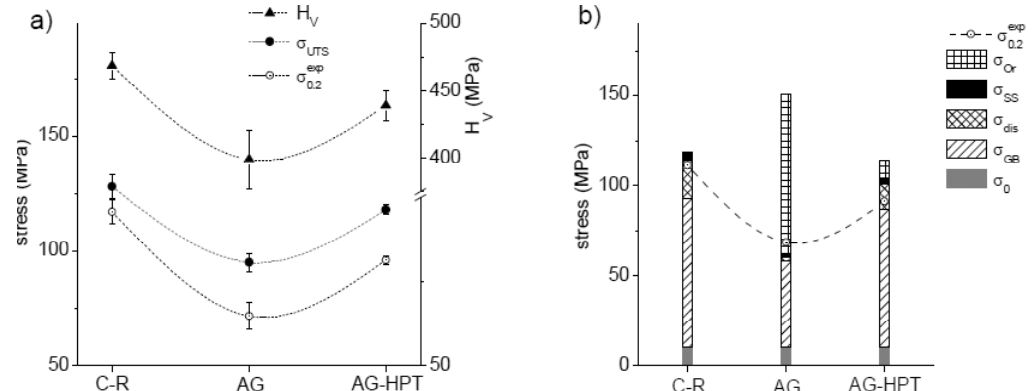
Fig. 5. a – experimentally obtained values of microhardness ( H stress ( exp  ) of Al–0.4Zr(wt.%) alloy in initial C–R state, after aging (AG–state) and subsequent HPT 0.2